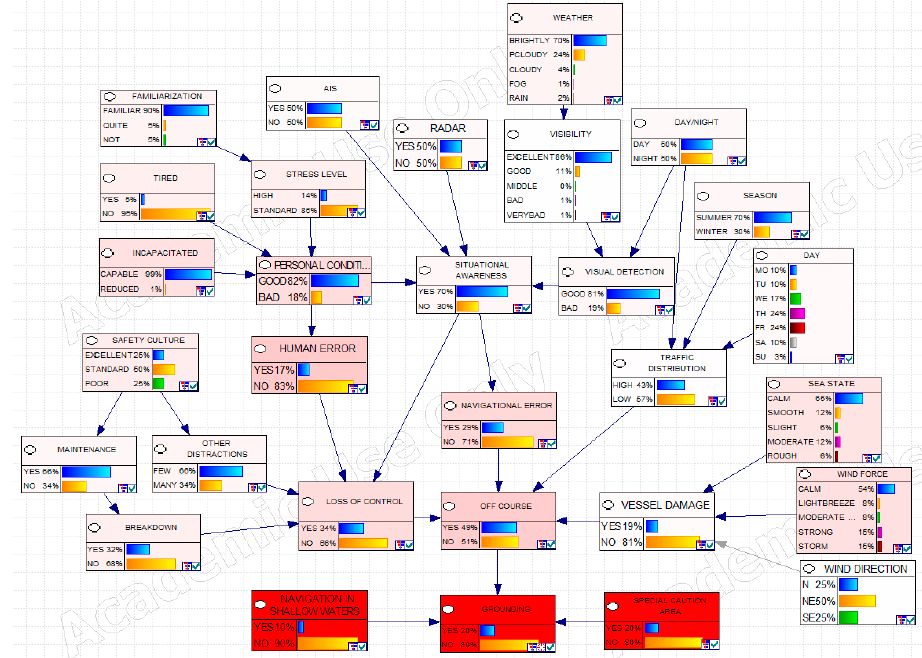
Figure 5. Sensitivity analysis for the grounding model when targeting “grounding”.